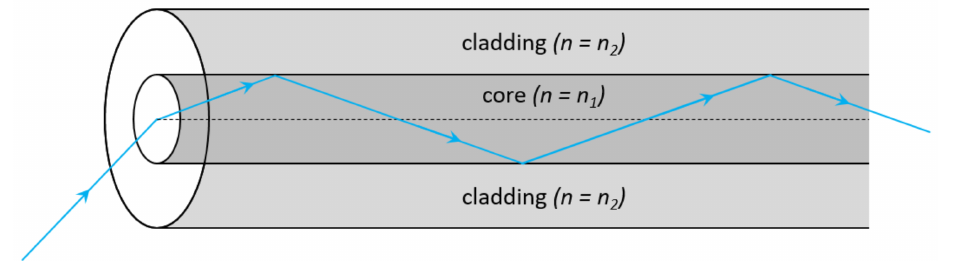
Figure 1. The geometry of an optical